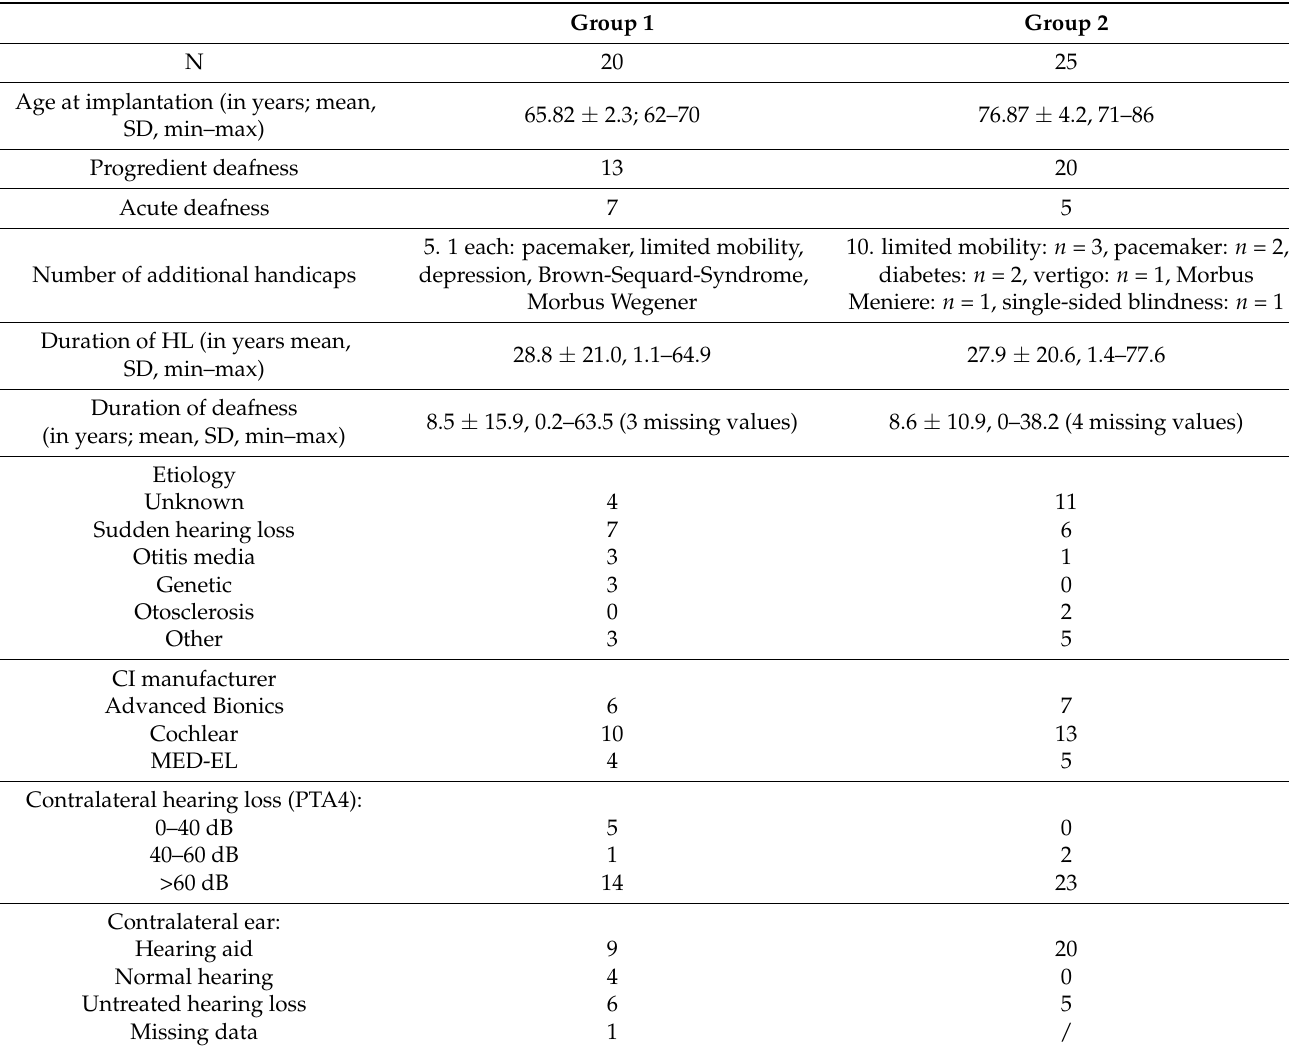
Table 1. Demographic information for each group. PTA4 = mean pure tone average at 0.5, 1, 2, 4 kHz. Group